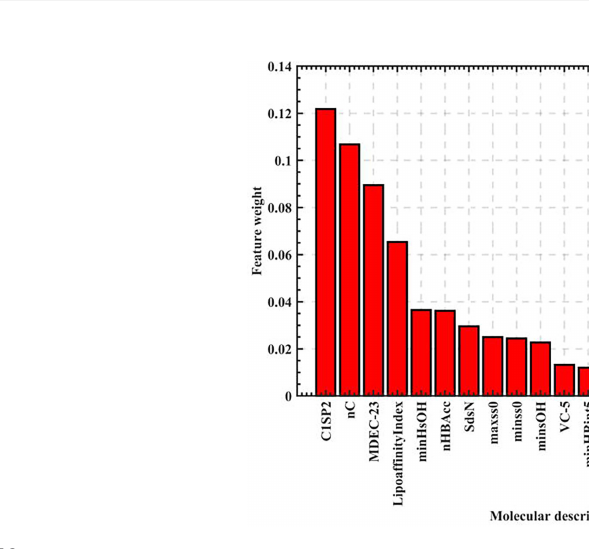
FIGURE 2 Top 20 ranking chart of feature weights.